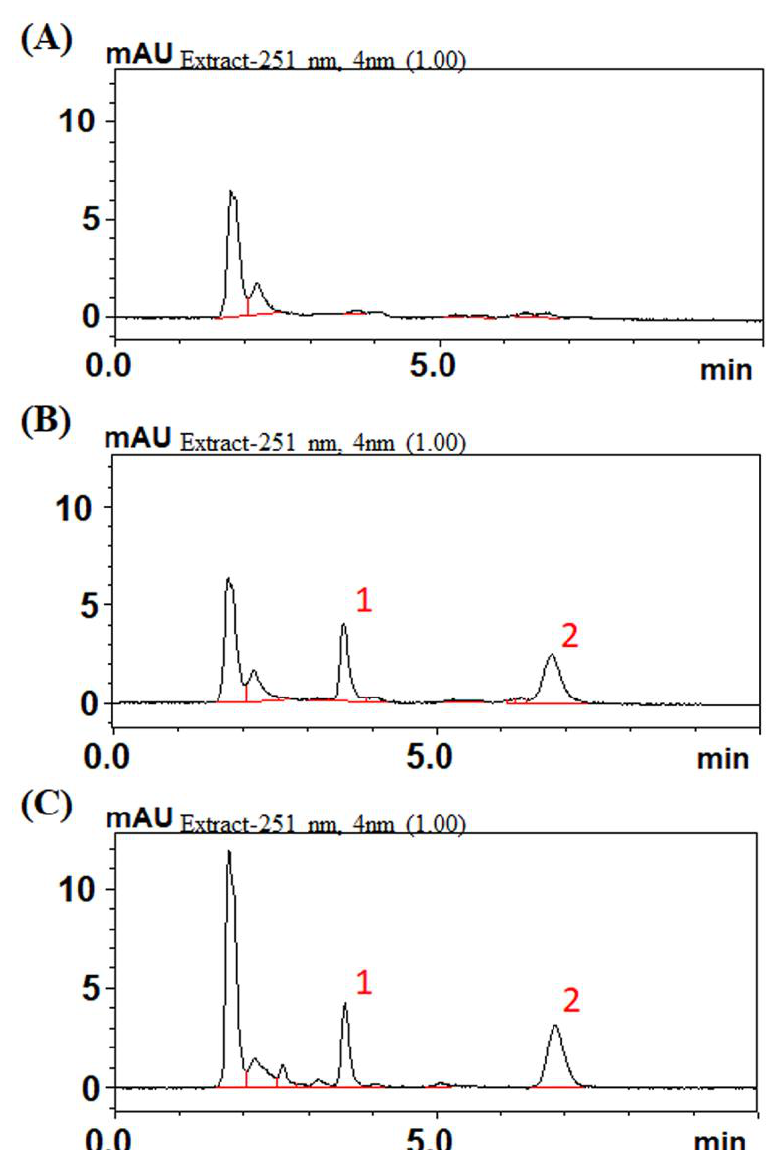
Figure 4. Chromatograms resulting from high-performance liquid chromatography for cabozantinib. ( A ) Blank. ( B ) Blank spiked with cabozantinib (1 µg/mL) and biochanin A (0.75 µg/mL). ( C ) Plasma scheme 60 min after cabozantinib administration (6 mg/kg, p.o.). Peak 1: biochanin A (0.75 µg/mL). Peak 2: cabozantinib (0.8 µg/mL).